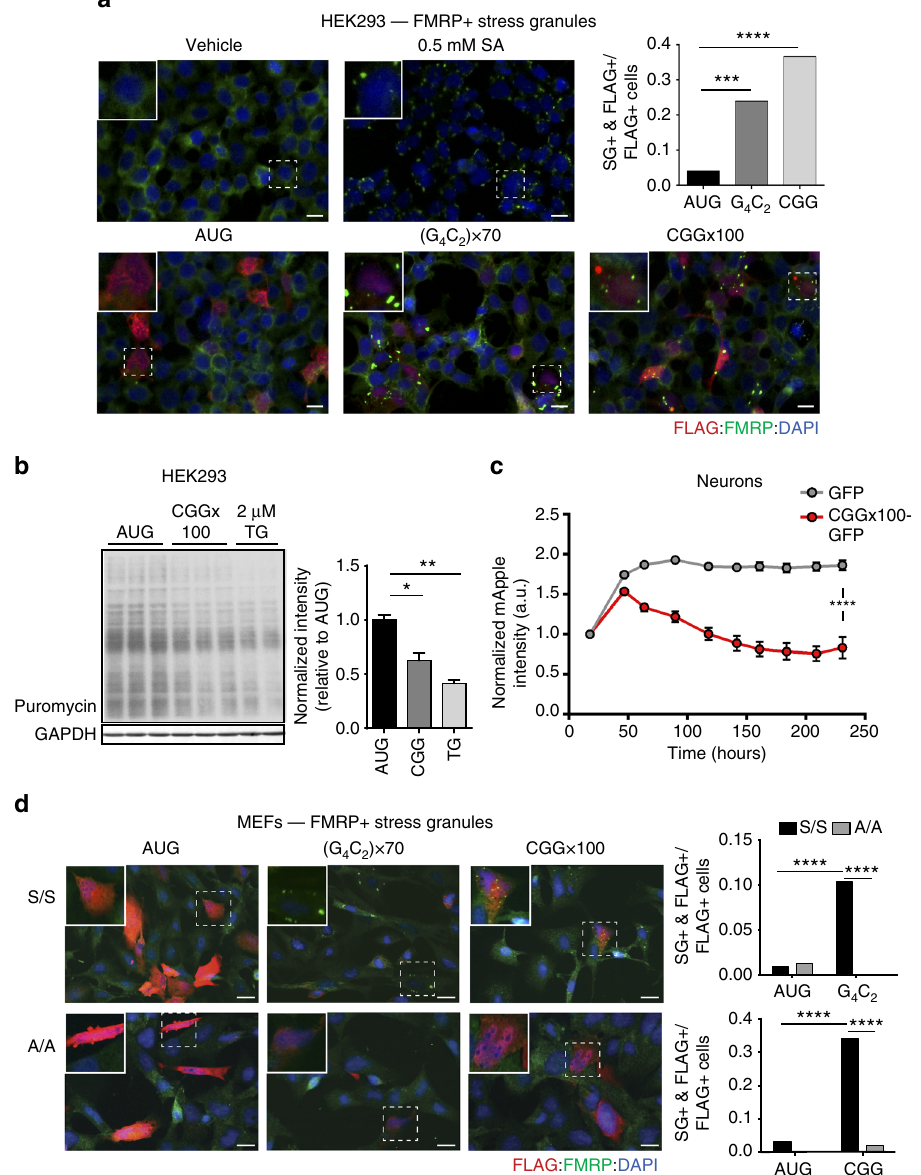
Fig. 6 CGG and G 4 C 2 repeat expansions induce phosphorylated-eIF2 α -dependent stress granules. a Top left: immuno fl uorescent images of HEK239 cells treated with vehicle or 0.5M SA. Bottom: immuno fl uorescent images of HEK239 cells expressing control, (G 4 C 2 )×70, or CGG×100 reporters, scale bar = 100 µ m. Top right: quanti fi cation of the proportion of FLAG-positive cells with FMRP-positive stress granules (SGs) for each genotype, n > 70. b Western blot and quanti fi cation of puromycin incorporation in cells transfected with control AUG-NLuc or CGG×100 reporter, or treated with 2 µ M TG as a positive control. GAPDH is used as a loading control. Graph represents mean ± SEM. c mApple fl uorescent intensity in primary rat cortical neurons co-transfected with GFP or CGG×100-GFP, longitudinally imaged with automated fl uorescent microscopy for 10 days following transfection, n > 68. Graph represents mean ± 95% con fi dence interval. d Left: immuno fl uorescent images of WT eIF2 α - S51 S/S and eIF2 α - S51 A/A MEFs expressing control, (G 4 C 2 )×70, or CGG×100 reporters, scale bar = 100 µ m. Right: quanti fi cation of the proportion of FLAG-positive cells with FMRP-positive SGs for each genotype, n > 40. FLAG marks reporter expressing cells, FMRP mark SGs. For a and d , Fisher ’ s exact test, ∗∗∗ p < 0.001; ∗∗∗∗ p < 0.0001. For b and c , two-tailed Student ’ s t test with Bonferroni and Welch ’ s correction, ∗ p < 0.05; ∗∗ p < 0.01; ∗∗∗∗ p <